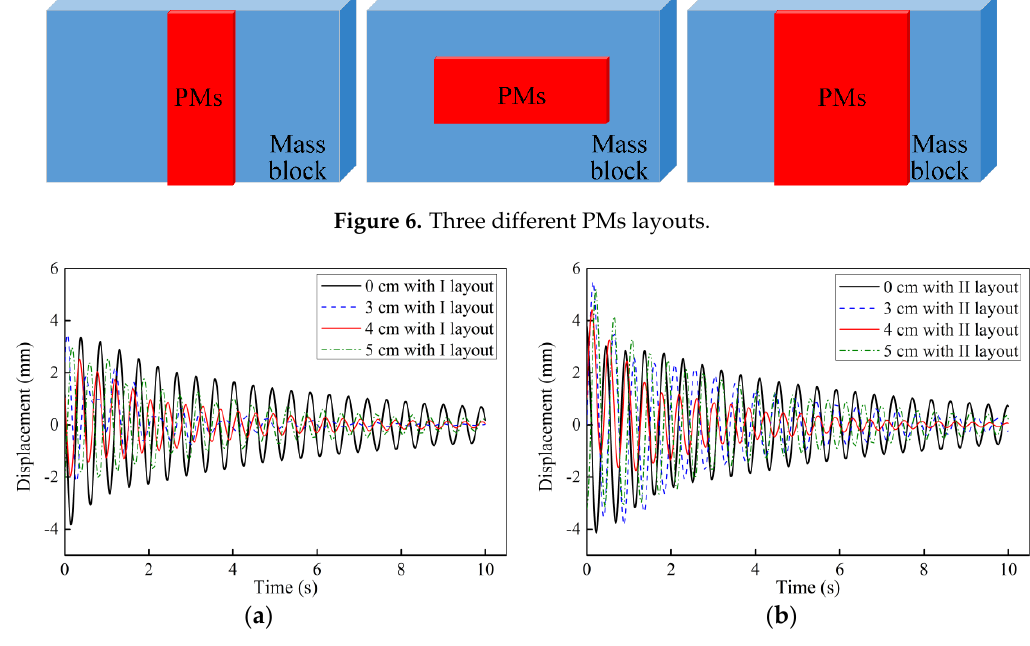
Figure 7. EC-TMD free attenuation curves of model tests: ( a ) Free attenuation curves of the PMs in I layout; ( b ) Free attenuation curves of the PMs in II layout. Table 2. The damping ratio of the EC-TMD system with different configurations.